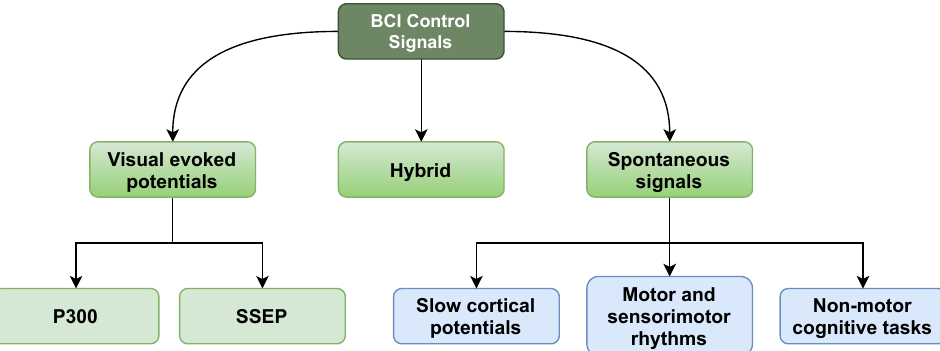
Figure 4. The basic architecture of BCI control